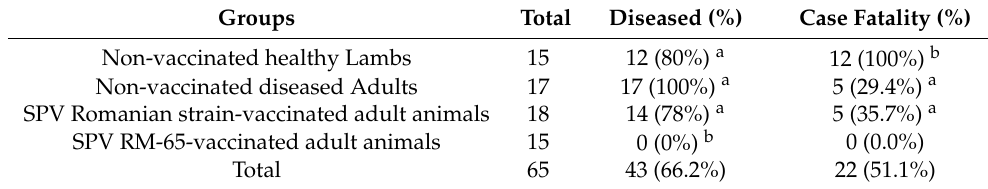
Figure 1. Gross pathology of sheeppox lesions: papular sheeppox lesions spread over the inner aspect of the fatty tail ( A ), variable size papules in the inner thigh region ( B ), dry thick scab lesions over the inner aspect of the fatty tail ( C ), abnormal udder showing apparent gross sheeppox lesions ( D ), variable size papules on the upper and lower lips ( E ), and black patch spots over the lung of a deceased sheep ( F ). Table 1. The incidence and case fatality of sheeppox among different groups of